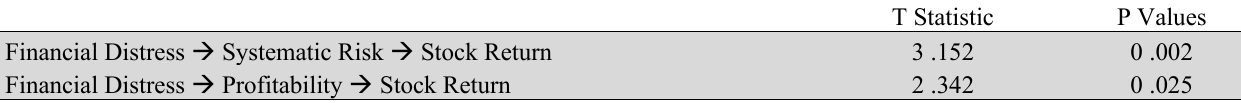
Specific Indirect Effect